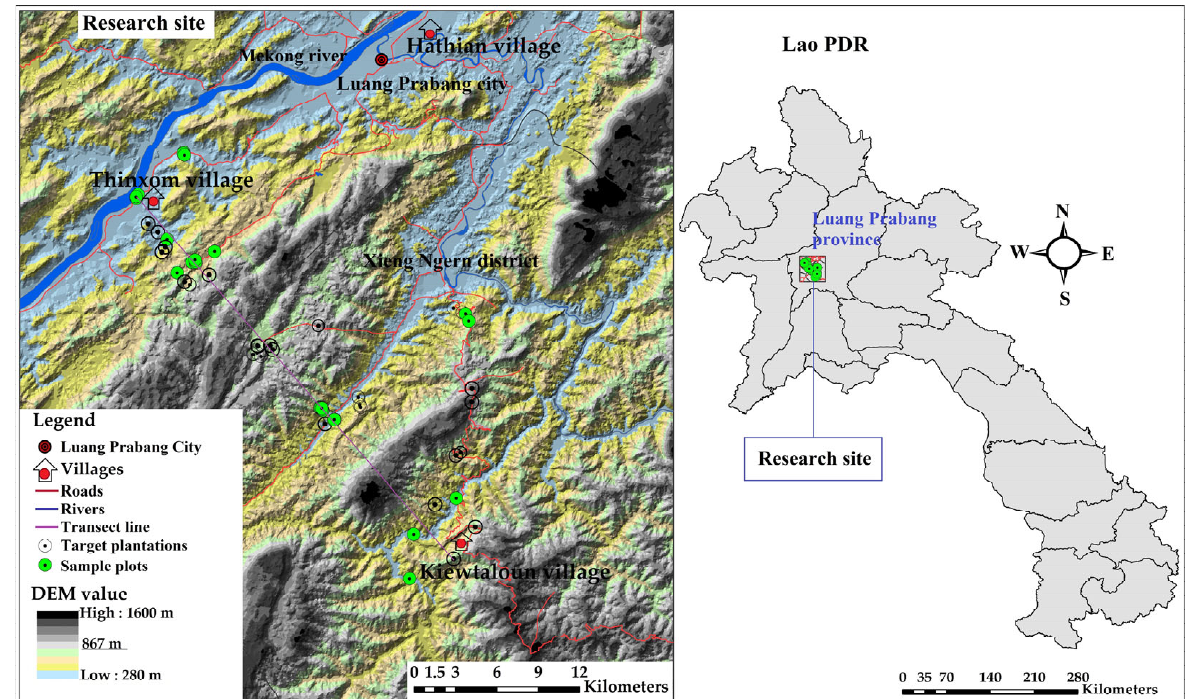
Figure 1. Research area showing transect line and sample plantation locations ( left ) and location within Lao PDR ( right ). Source: Drawn by the authors based on Mekong Geographic Information Systems data [29]. DEM, digital elevation model.